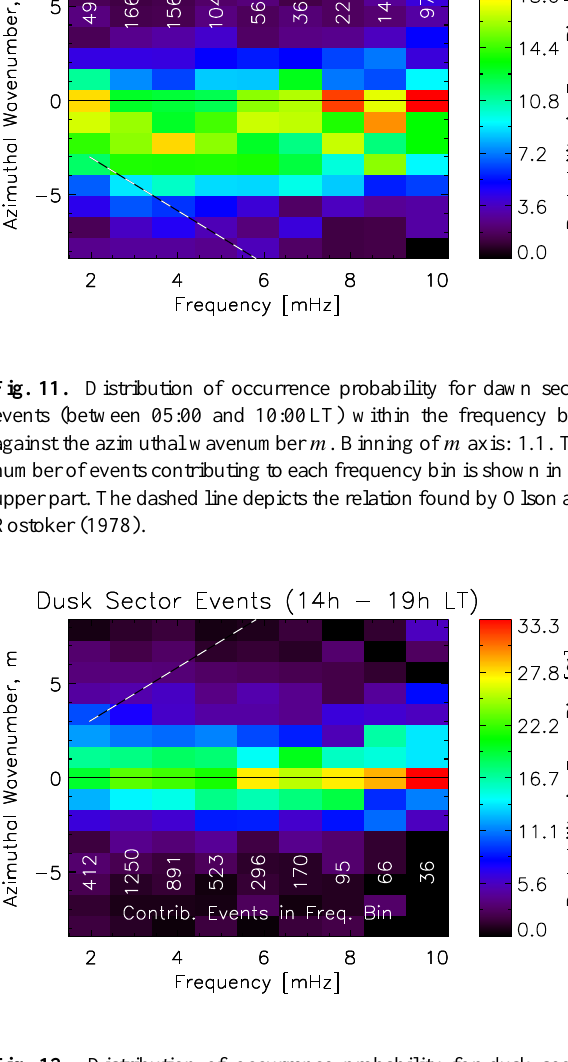
Fig. 12. Distribution of occurrence probability for dusk sector events (between 14:00 and 19:00LT) within the frequency bins against the azimuthal wavenumber m . Binning of m axis: 1 . 1. The number of events contributing to each frequency bin is shown in the lower part. The dashed line depicts the relation found by Olson and Rostoker (1978).